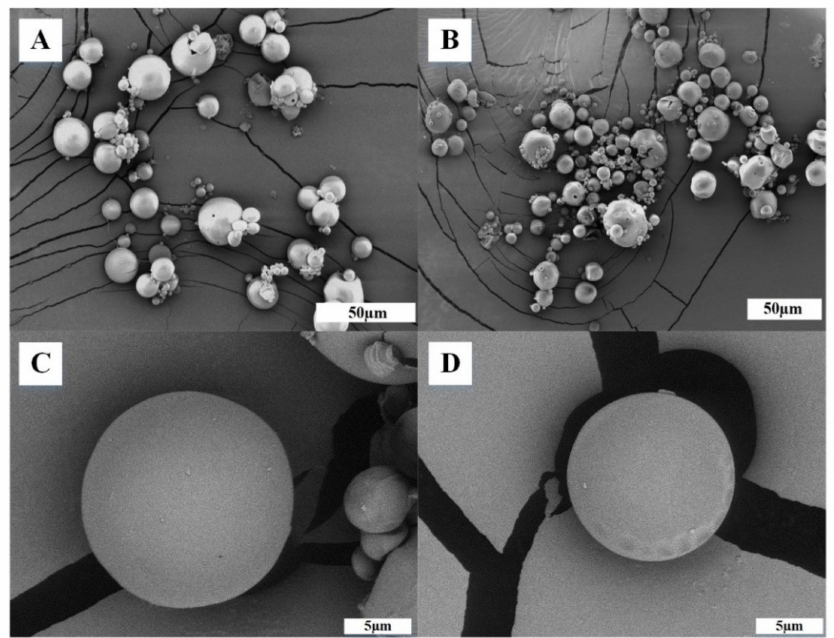
Figure 4. SEM pictures of surface of PLGA microcapsules ( A , C ) without and ( B , D ) with VANKA.